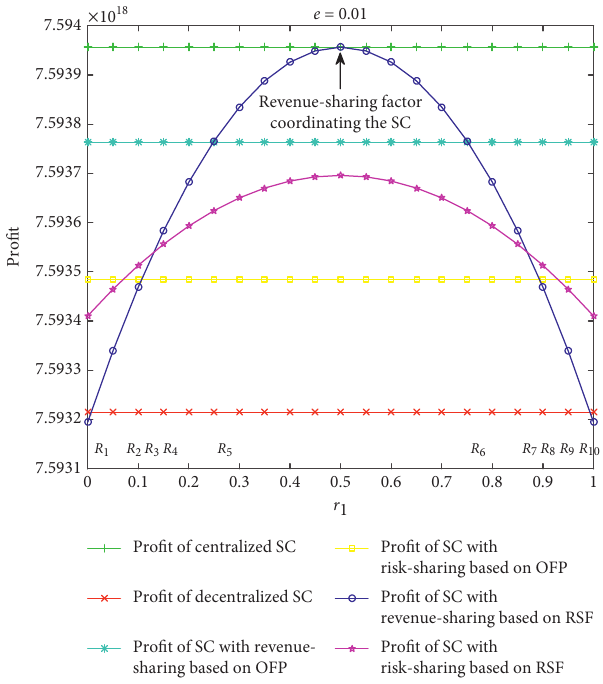
Figure 4: Change trends of the SC performance on the combined sharing